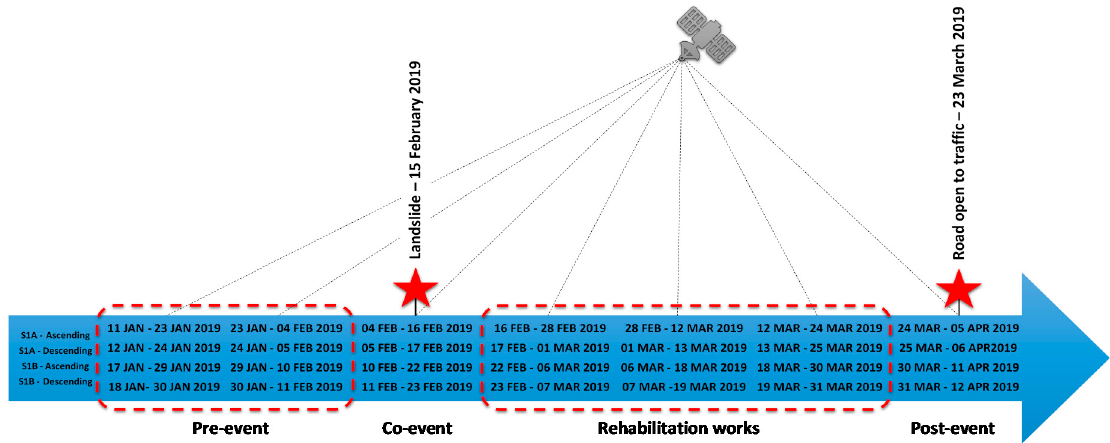
Figure 9. Timeline of Synthetic Aperture Radar (SAR) acquisitions and events.